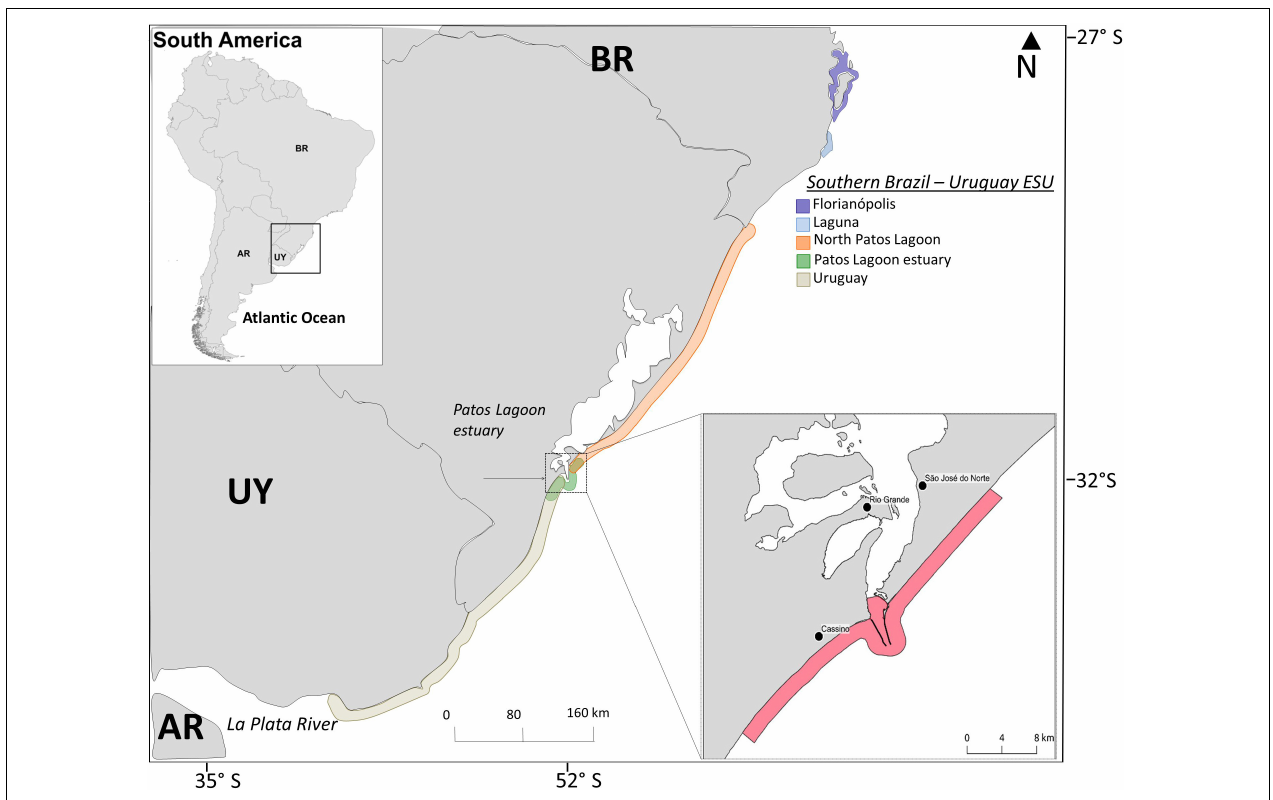
FIGURE 1 | Map showing approximate geographic boundaries of the five bottlenose dolphin populations/Management Units (color contoured lines) identified along the Southern-Brazil/Uruguay Evolutionarily Significant Unit (SB-U ESU) (see Fruet et al., 2014 for details), and the recently implemented dolphin protection area in southern Brazil (denoted by dashed lines) where boat-based gillnet fisheries are banned (Ministério da Agricultura, Pecuária e Abastecimento,